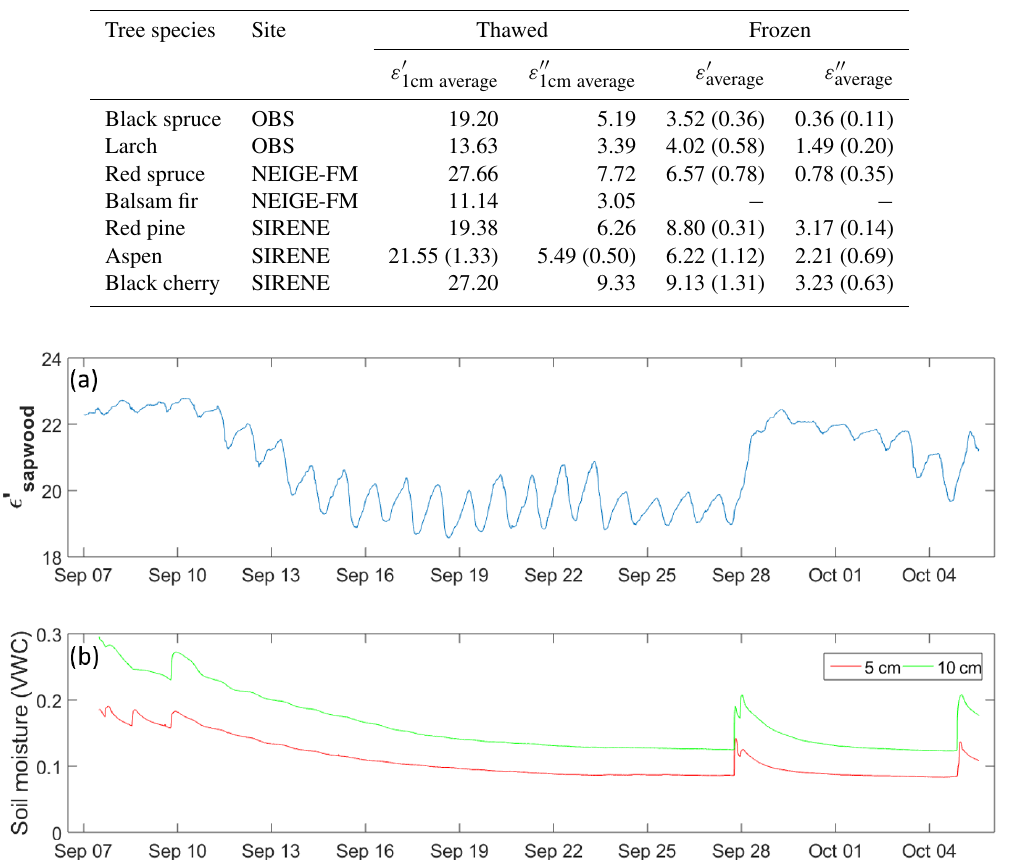
Figure 8. (a) Daily cycle of red pine sapwood L-band permittivity (unitless) at the SIRENE site, and (b) soil moisture at 5 and 10cm of depth (EC-TM